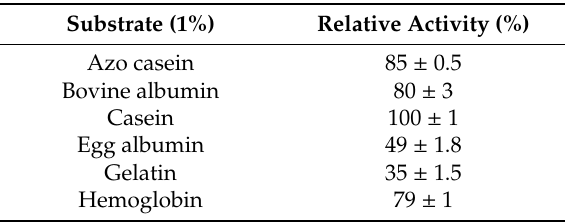
Table 2. Overview of substrate-dependent protease activity.